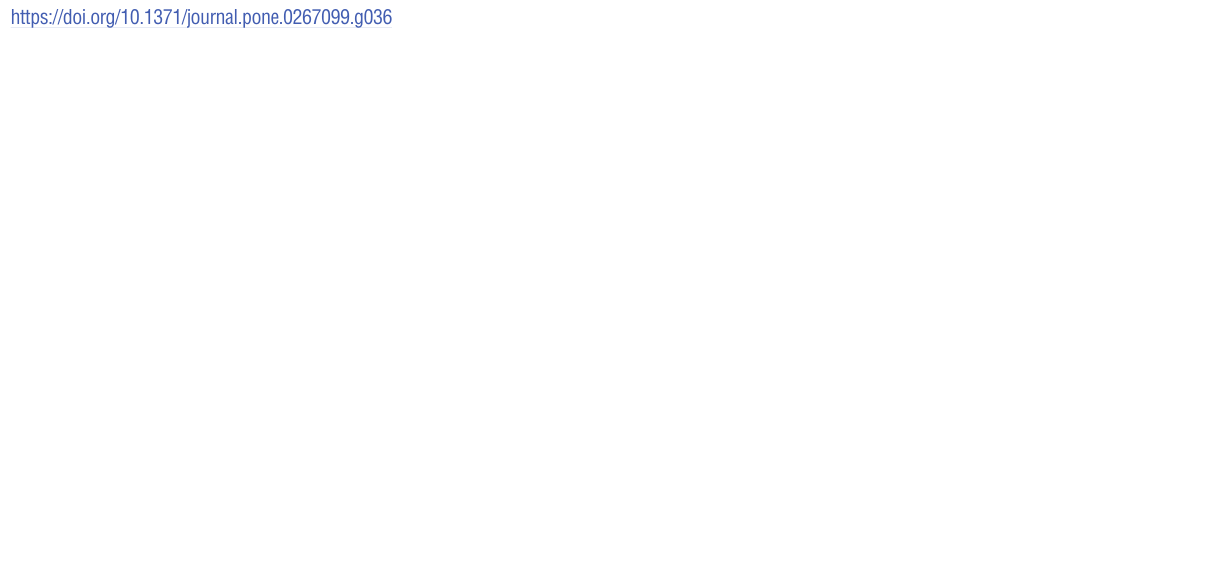
PLOS ONE | https://doi.org/10.1371/journal.pone.0267099 April 28,